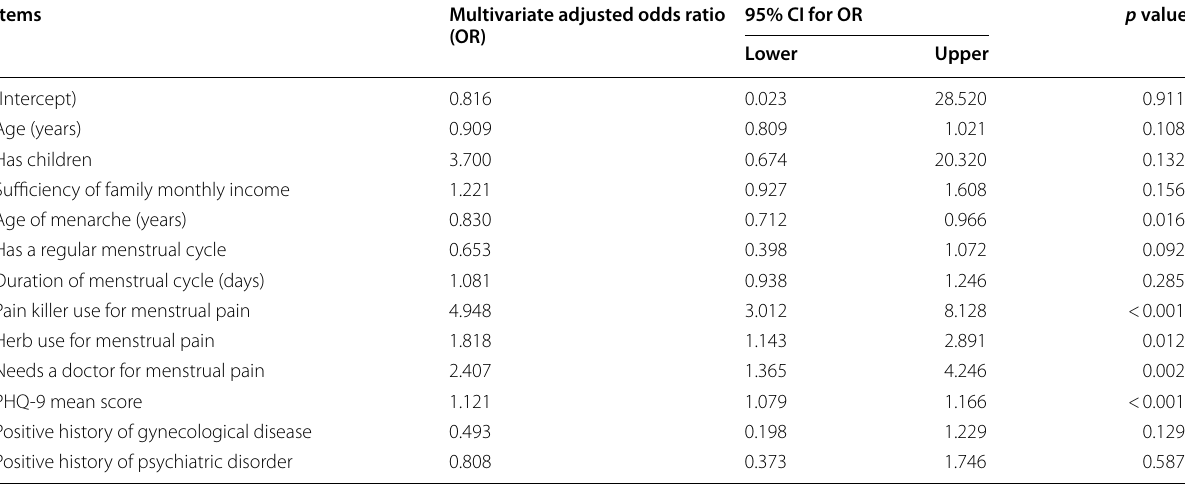
Dependent variable: Severe dysmenorrhea (WALIDD score > cutoff of 9)